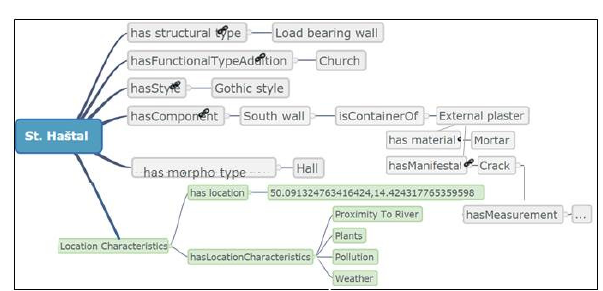
Figure 12. Location characteristics profile